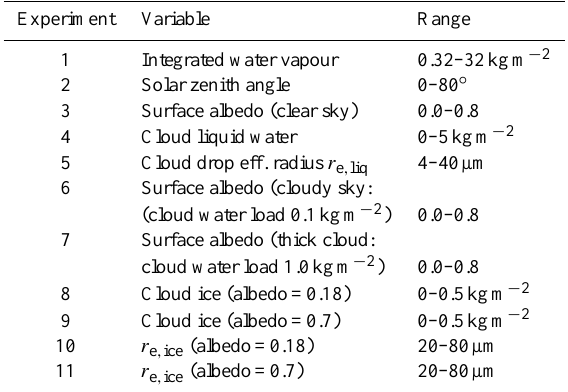
Table 1. The benchmark radiative transfer experiments. Table 2. Coefficients used for the Nielsen liquid cloud optical pa- rameterisation. The columns show the wavelength bands ( i )